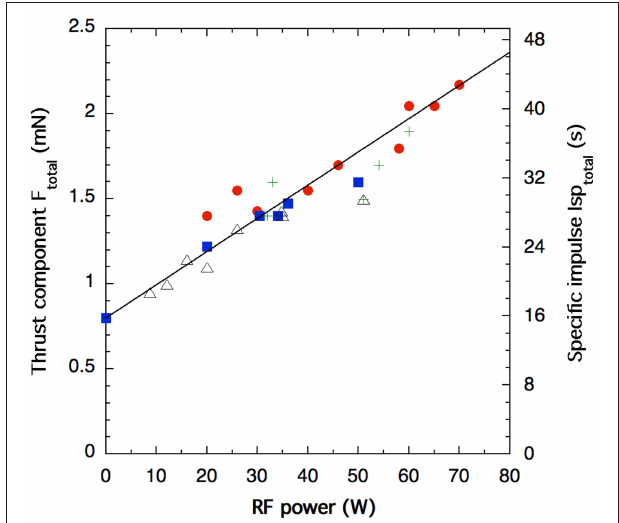
FIGURE 3 | F total thrust component and I sp total specific impulse measured as a function of rf power for four data sets: series 1 (filled red circles), series 2 (open triangles), and series 4 (green crosses) respectively taken on days 1, 2, and 3 for continuous plasma excitation and series 3 (filled blue squares) taken on day 2 for pulsed plasma excitation. The xenon gas flow is constant at 52.5 sccm. The error bar on thrust components is ± 0.25 mN. A solid black line is added as a visual